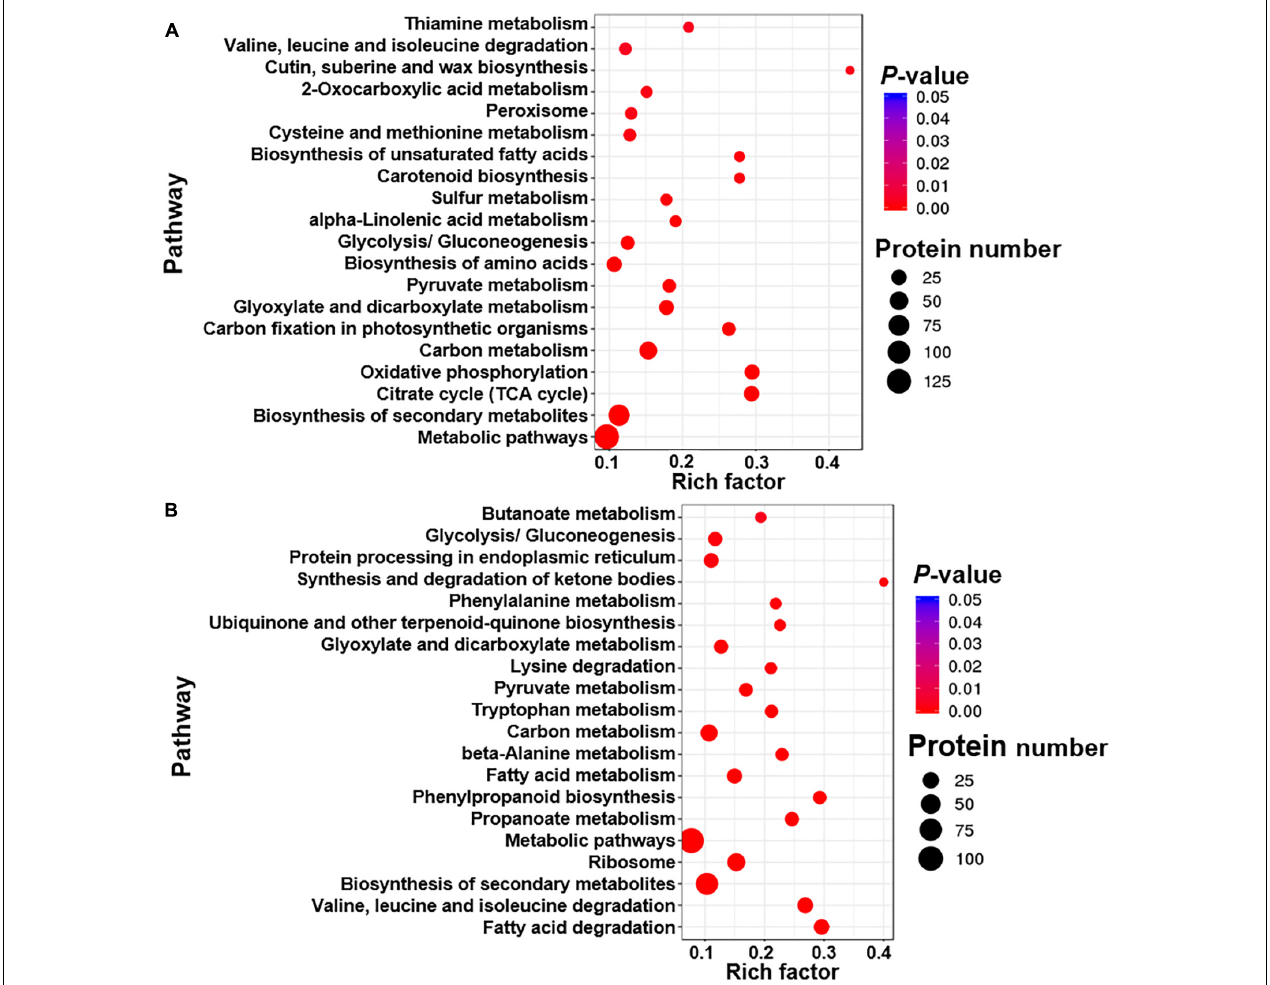
FIGURE 5 | Top 20 enriched pathway terms of differentially expressed proteins in FS280 vs. WT. (A) Enriched pathways based on the upregulated proteins. (B) Enriched pathways based on the downregulated proteins. The rich factor is defined as the ratio of differentially expressed proteins to all proteins that were annotated in this pathway term. The dot size represents the number of differentially expressed proteins that were annotated to the